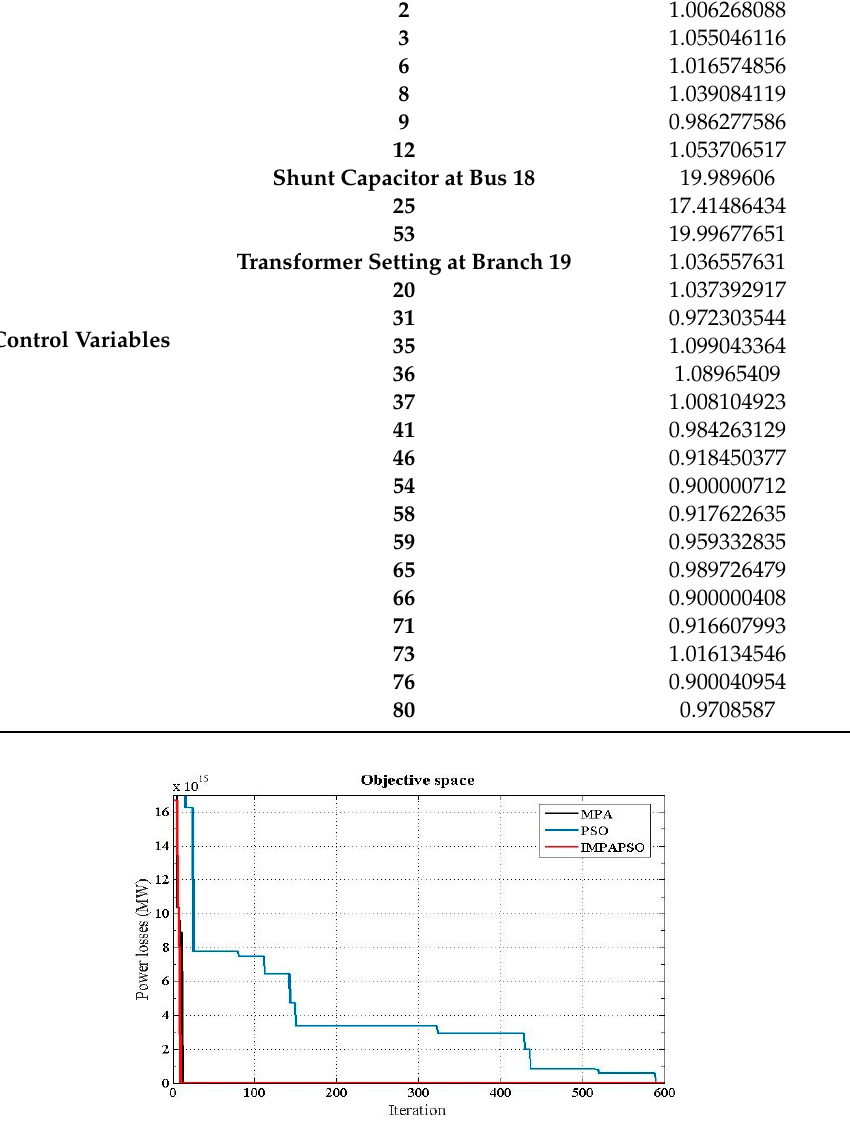
Figure 7. Convergence of PSO, MPA, and IMPAPSO in the first case of the IEEE 57-bus system.